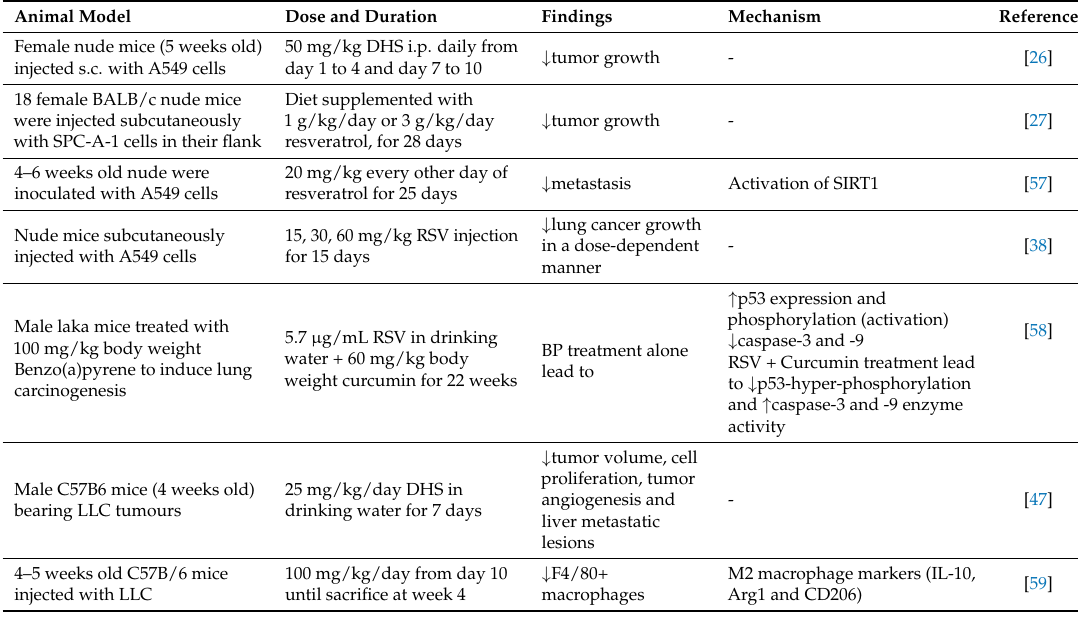
Table 3. Effects of resveratrol (RSV) against lung cancer: in vivo